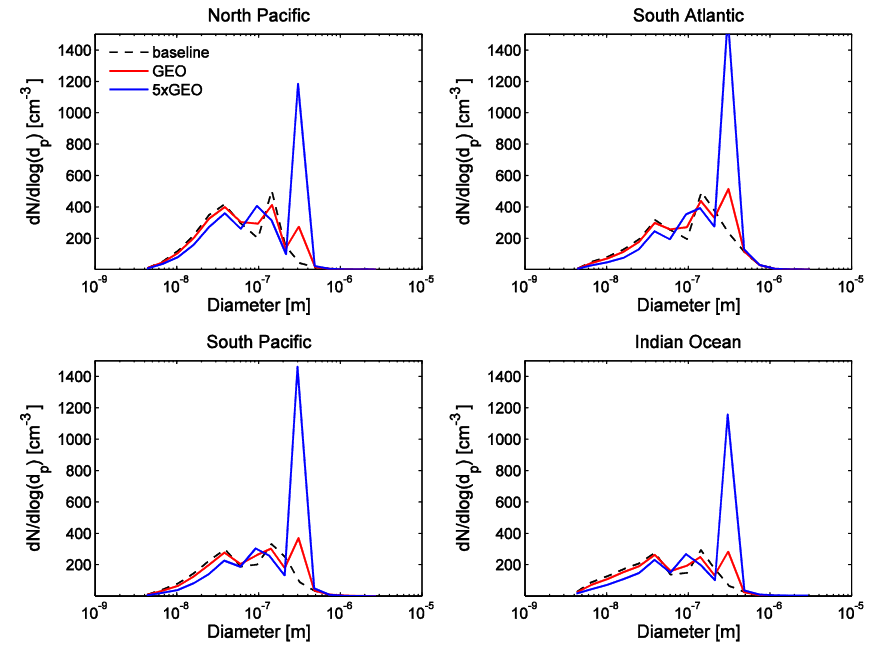
Fig. 6. Annual mean size distributions in the four geoengineered regions at 1km Figure 6: Annual mean size distributions in the four geoengineered regions at 1 km altitude.